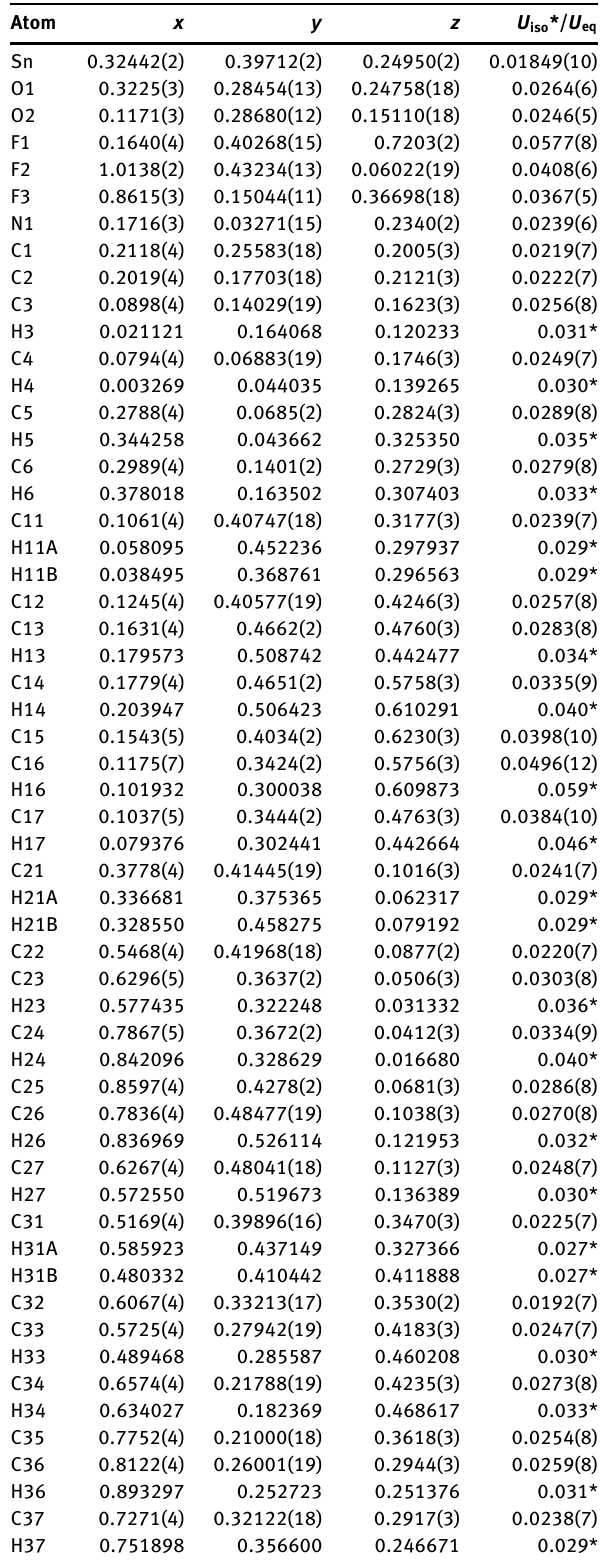
Table 2: Fractional atomic coordinates and isotropic or equivalent isotropic displacement parameters (Å 2